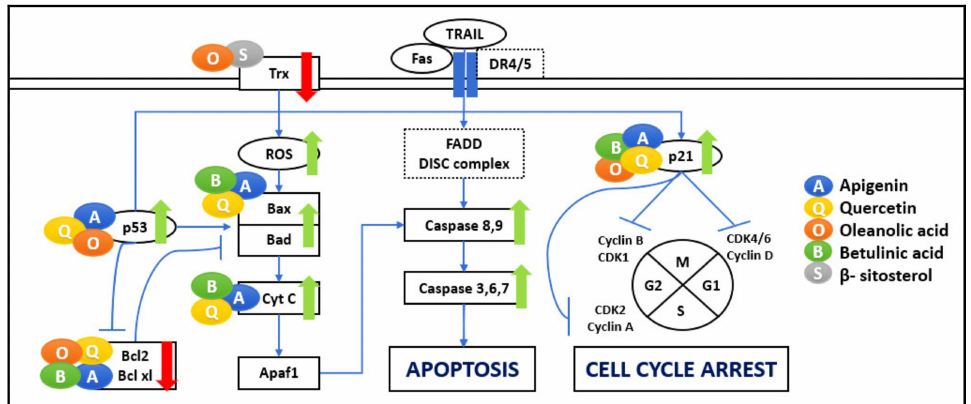
Figure 5. Apoptosis and cell cycle arrest. The five bioactive compounds show a range of immunomod- ulatory activities towards apoptosis and the cell cycle. Their effects on significant pathways include regulation of cell survival and cell cycle progression. These bioactive compounds are shown as coloured circles and are indicated alongside their respective molecular targets (Blue: Apigenin, Yellow: Quercetin, Orange: Oleanolic acid, Green: Betulinic acid, Grey: β -Sitosterol). The bold red arrows indicate the downregulation of respective pathways, and bold green arrows indicate the upregulation of the particular pathway. The entities of bold square boxes represent different signaling molecules/complexes. The entities of dotted square boxes represent different receptors for signaling pathways. The entities of circle boxes represent the inducers/activators of the particular pathways. → represents direct activation and (cid:97) represents